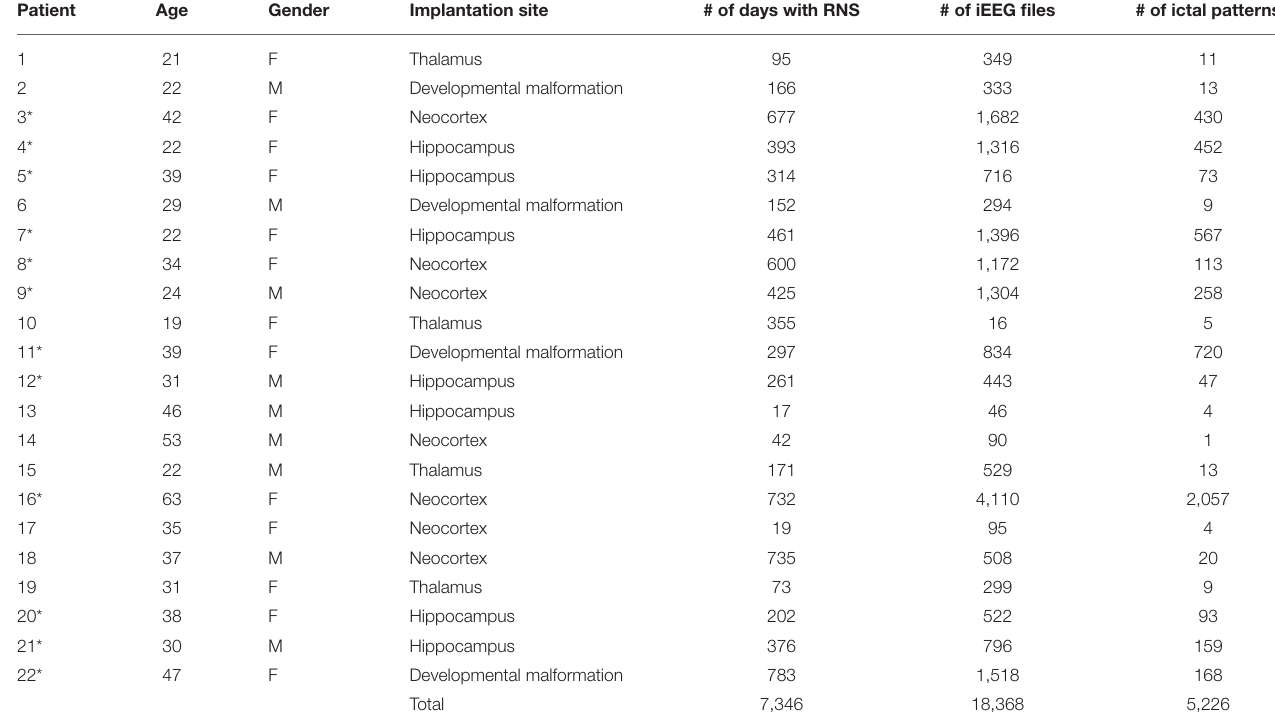
* Patients with > 35 iEEG ictal patterns used in the testing dataset.